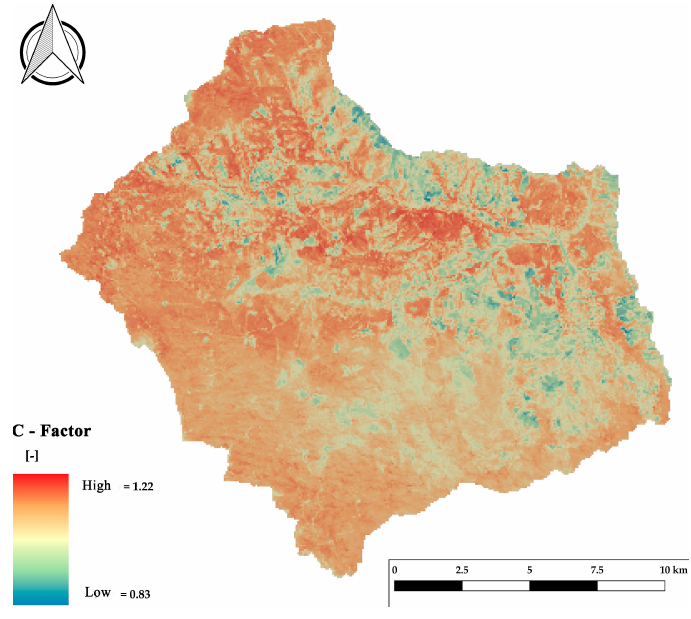
Figure 6. C-Factor map.